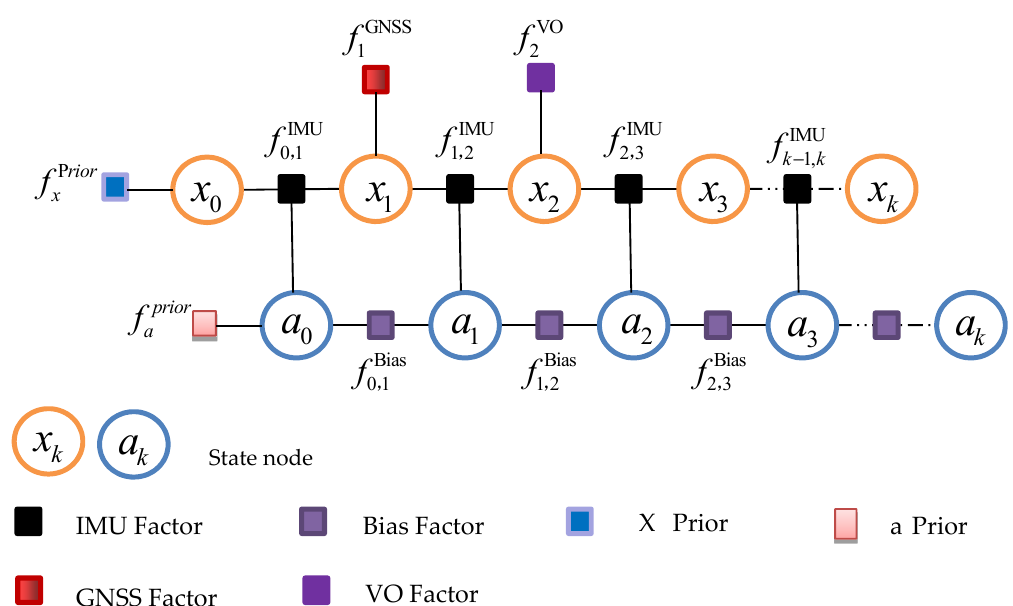
Figure 2. A multi-source fusion framework for the factor graph.